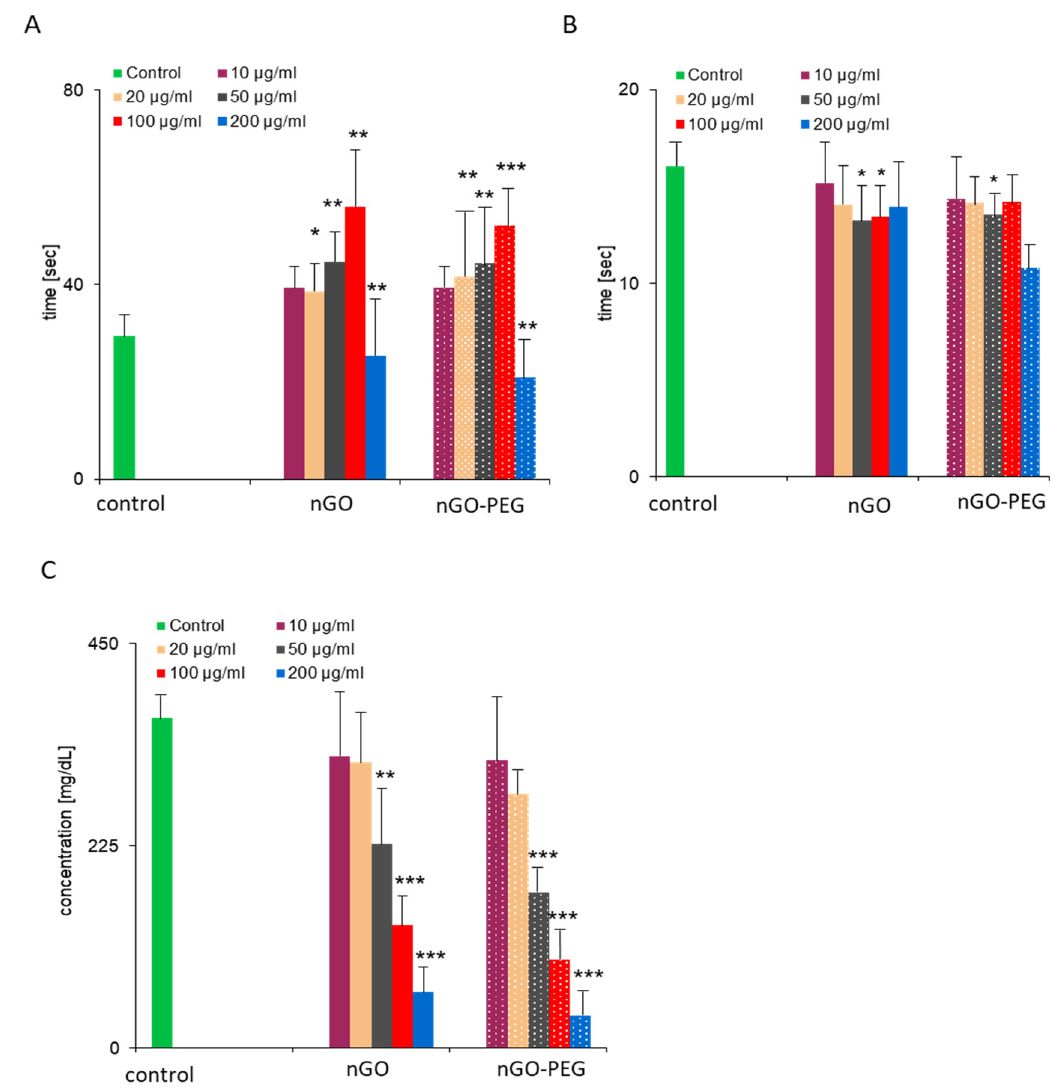
Figure 4. Measurement of plasma coagulation time and fibrinogen concentration: Fresh human plasma was co-incubated with 100 μ g/mL of graphene derivatives for 30 min at 37 °C. Plasma coagulation was induced by the addition of sodium citrate and activated partial thromboplastin time (aPTT) ( A ); prothrombin time (PT) ( B ) and fibrinogen concentration ( C ) were recorded, respectively. One-way analysis of variances with Dunnett’s multiple comparison test was applied. Significant results are indicated as * p <0.05; ** p <0.01 and *** p <0.001.